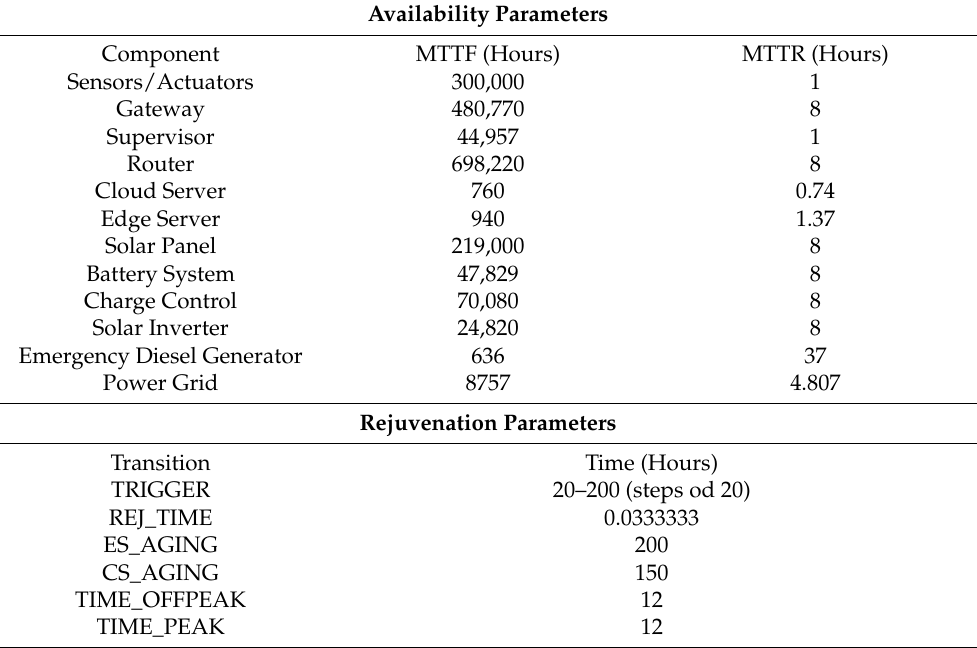
Table 7. Input parameters for proposed models.